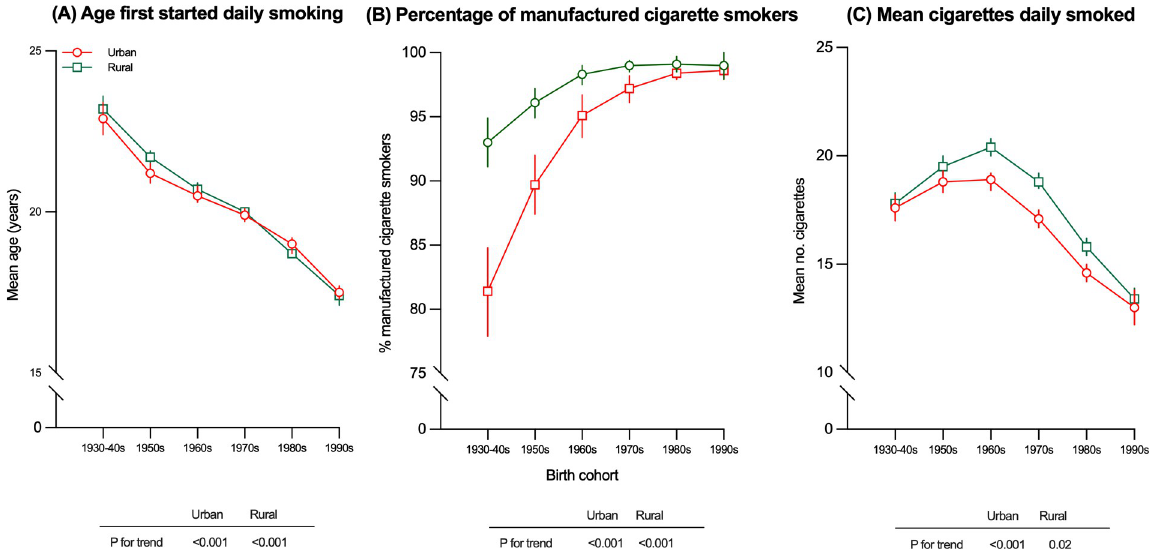
Fig 3. Age first stared daily smoking (A), percentage of manufactured cigarette smokers (B), and mean cigarettes daily smoked (C) among male regular smokers aged 18–69 years, by year of birth. Data from the 2007, 2010, 2013, 2015, and 2018 CCDRFS. CCDRFS, China Chronic Disease and Risk Factor Surveillance, CI, confidence